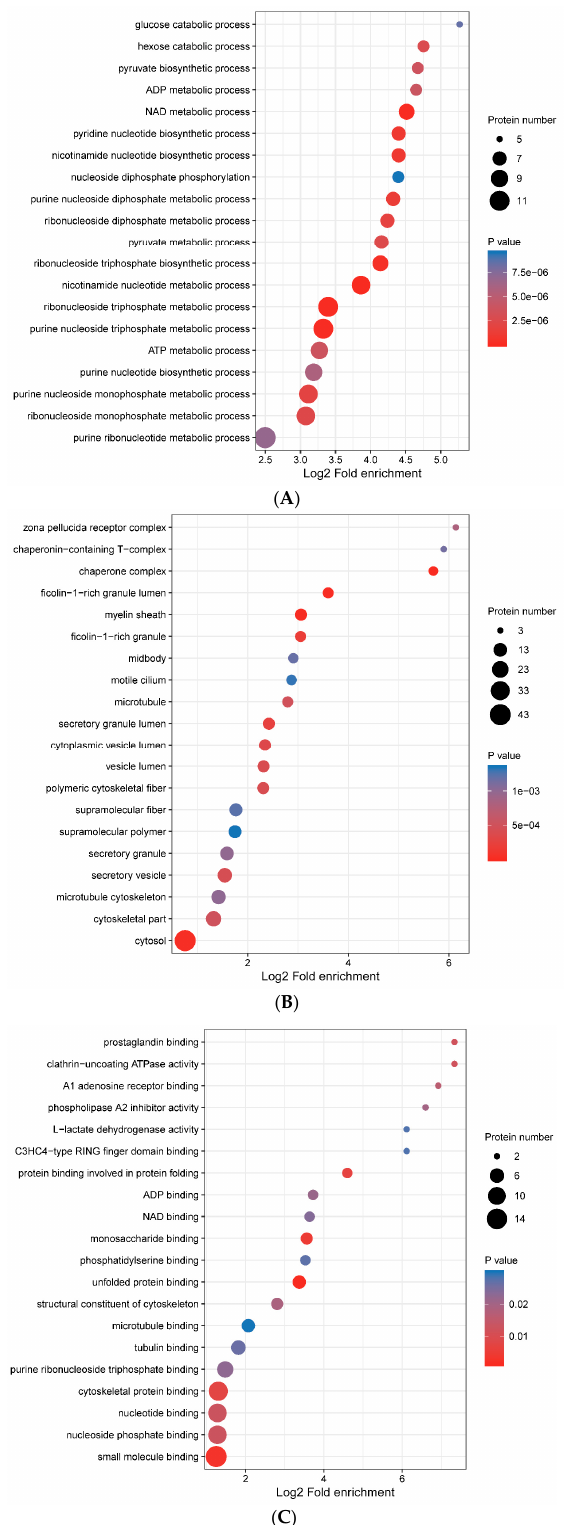
Figure 5. GO enrichment bubble plot of interferon-stimulated gene product 15 (ISG15)-conjugated proteins under different Gene Ontology (GO) categories . ( A ) GO enrichment bubble plot under the GO category of biological process. ( B ) GO enrichment bubble plot under the GO category of cellular component, ( C ) GO enrichment bubble plot under the GO category of molecular function.